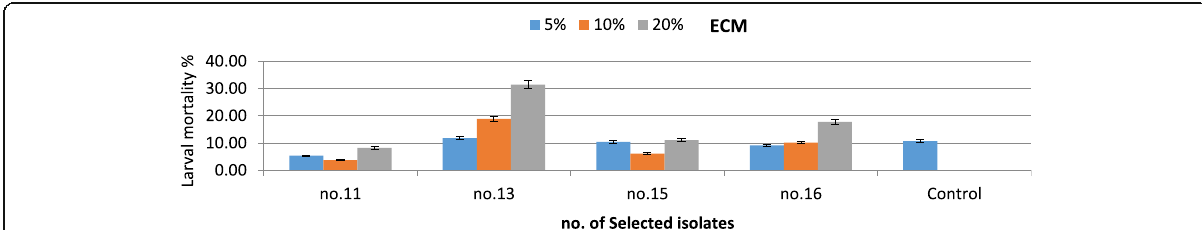
Fig. 4 Effect of different concentrations of ECM from the 4 selected isolates on mortality percentage of adults represented as means (M ± SE), and statistical treatments were performed using ANOVA for differences comparing means in each concentration separately using Tukey ’ s HSD test. ANOVA parameters of 5, 10, and 20% concentrations respectively were LSD = 1.628, 1.711, 1.509; P < 0.05